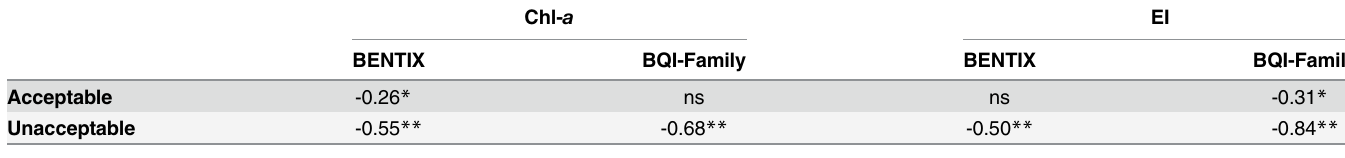
Fig 4. Non-metric multi dimensional scaling (nMDS) plot of macrobenthic data with stations labeled after the Ecological Status defined by means of the Benthic Quality Index — Family index. The ellipse surrounds the stations with “ Bad ” or “ Poor ” Ecological Status in the water column as indicated in Fig 1. doi:10.1371/journal.pone.0141071.g004 Table 6. Results of Spearman correlation analysis between water column and benthic indices for two groups of stations based on the Ecological Status of the benthic indicators, i.e. “ acceptable ” ( “ High ” or “ Good ” ) and “ unacceptable ” ( “ Bad ” , “ Poor ” or “ Moderate ” ). Chl- a , chlorophyll a ; EI, Eutrophic Index; BQI-Family, Benthic Quality Index – Family; BENTIX, Benthic